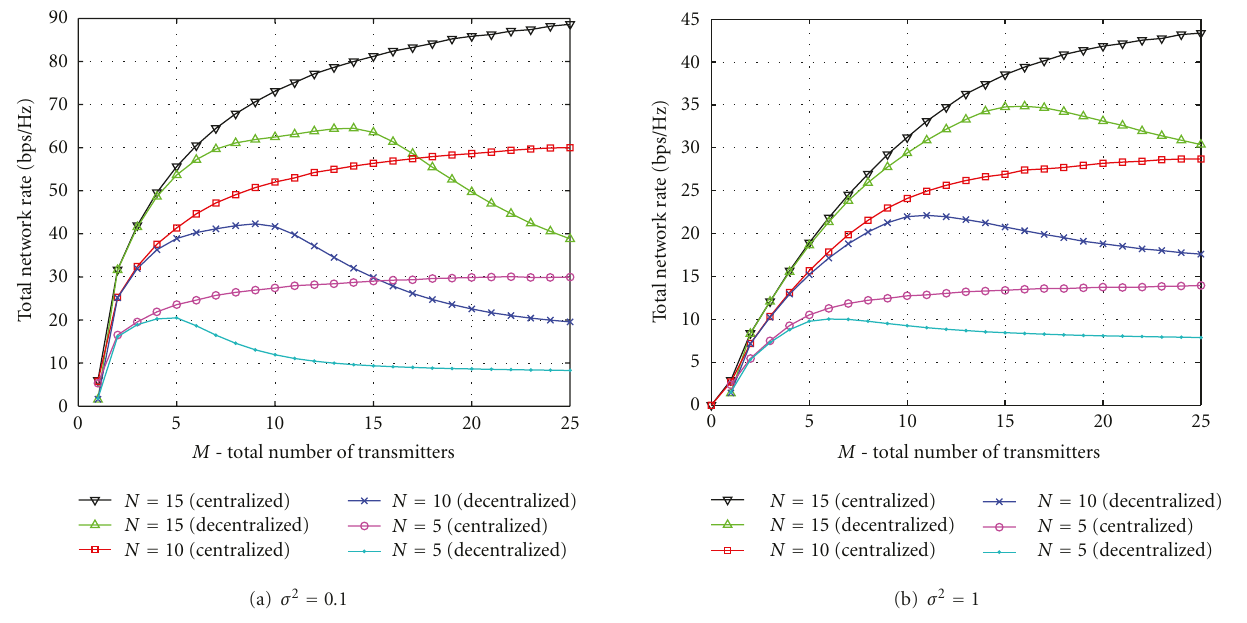
Figure 4: Average total network rate, decentralized versus centralized optimality.